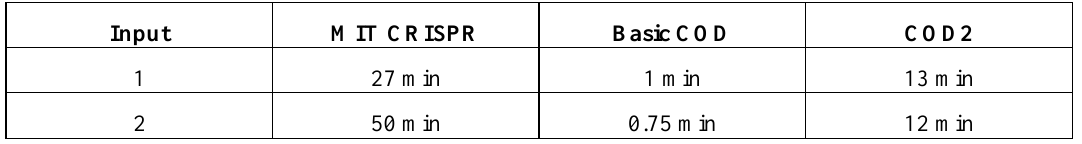
Table 1: Computational time lapses of MIT CRISPR, basic COD and COD2 Input MIT CRISPR Basic COD